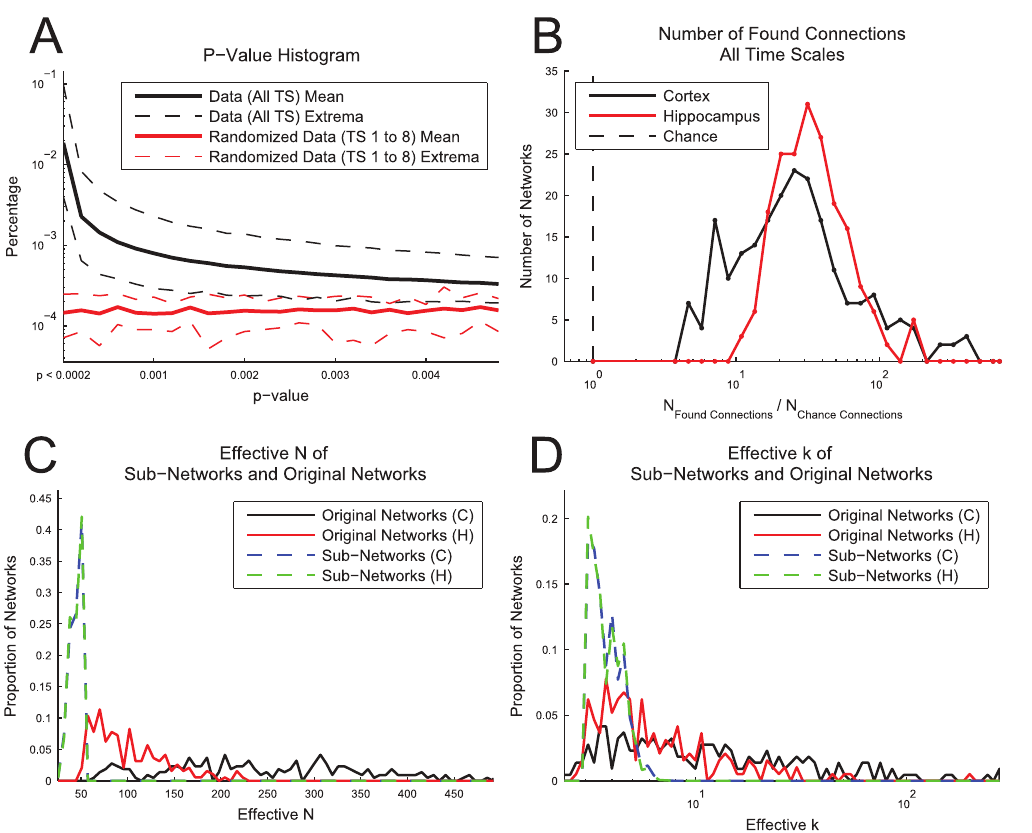
Fig. 12. Connectivity statistics. ( A ) TE p-value histogram for real and randomized data. Real data show many more pairs of neurons with low p-values compared to randomized data. In this analysis, the p-value threshold was set at less than 0.001. The extrema correspond to the time scale with the largest or smallest percentage value for a given p-value. ( B ) Number of found connections. The number of connections found in each network was at least 4 times larger than expected by chance, with most networks containing 10 to 100 times more connections than expected by chance. ( C ) Effective N values. The effective N for each network is the number of connected nodes in the network. The mean ¡ STD in the original data (sub-networks) was 241 ¡ 103 (42 ¡ 7) for cortical networks and 128 ¡ 54 (42 ¡ 7) for hippocampal networks. ( D ) Effective k values. The effective k for each network is the average number of connections (degree) per neuron. The mean ¡ STD in the original data (sub-networks) was 22 ¡ 30 (3.7 ¡ 0.7) for cortical networks and 11 ¡ 18 (3.7 ¡ 0.8) for hippocampal networks. Note that the sub-network procedure significantly reduced the variability of the effective N and k values, as well as the differences in effective N and k between tissue